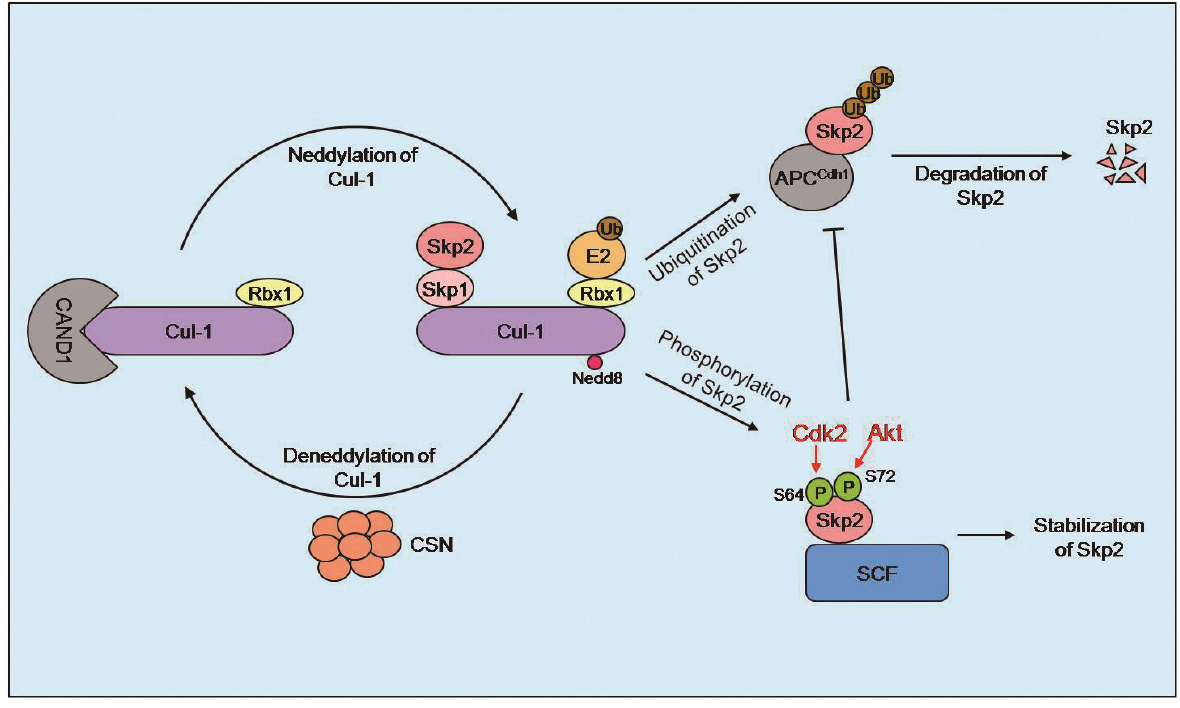
FIGURE 3. Regulation of Skp2 protein stability and the Skp2 SCF complex formation. The E3 ubiquitin ligase APC/Cdh1 complex ubiquitinates Skp2 through its binding to the D-box of Skp2 and leads to Skp2 degradation. Phosphorylation of Skp2 at Ser 64 and Ser 72 by Cdk2 and Akt, respectively, disrupts the interaction between Cdh1 and Skp2, thereby stabilizing Skp2. The formation of the Skp2 SCF complex can be regulated by neddylation and deneddylation cycles of Cul-1. The isopeptidase COP9 signalosome (CSN), consisting of an eight-subunit protein